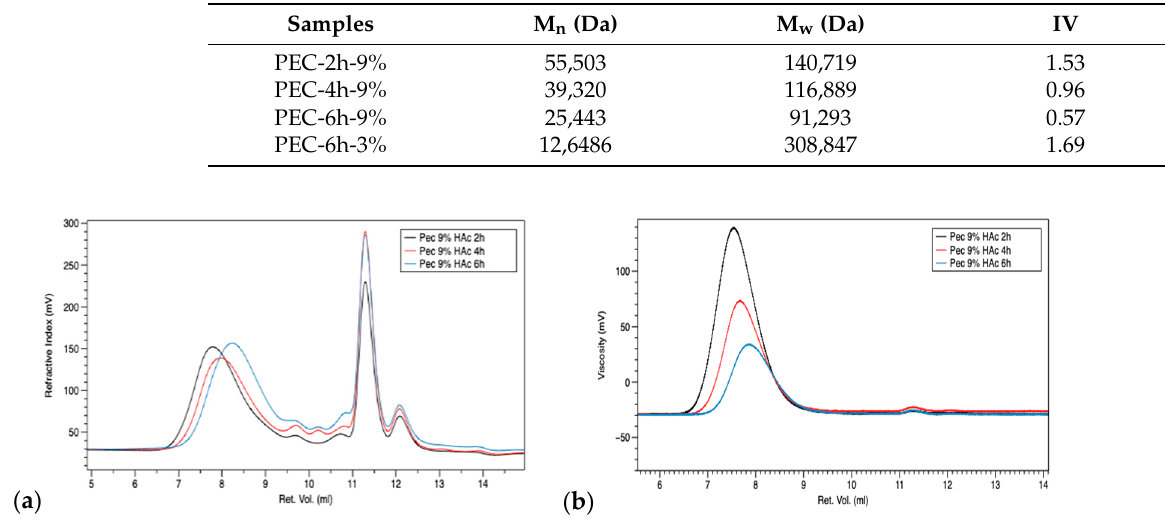
Figure 1. Refractive index ( a ) and viscometer ( b ) chromatograms of pectins at 9% HAc and different extraction times: 2 h—black, 4 h—red, 6 h—blue.